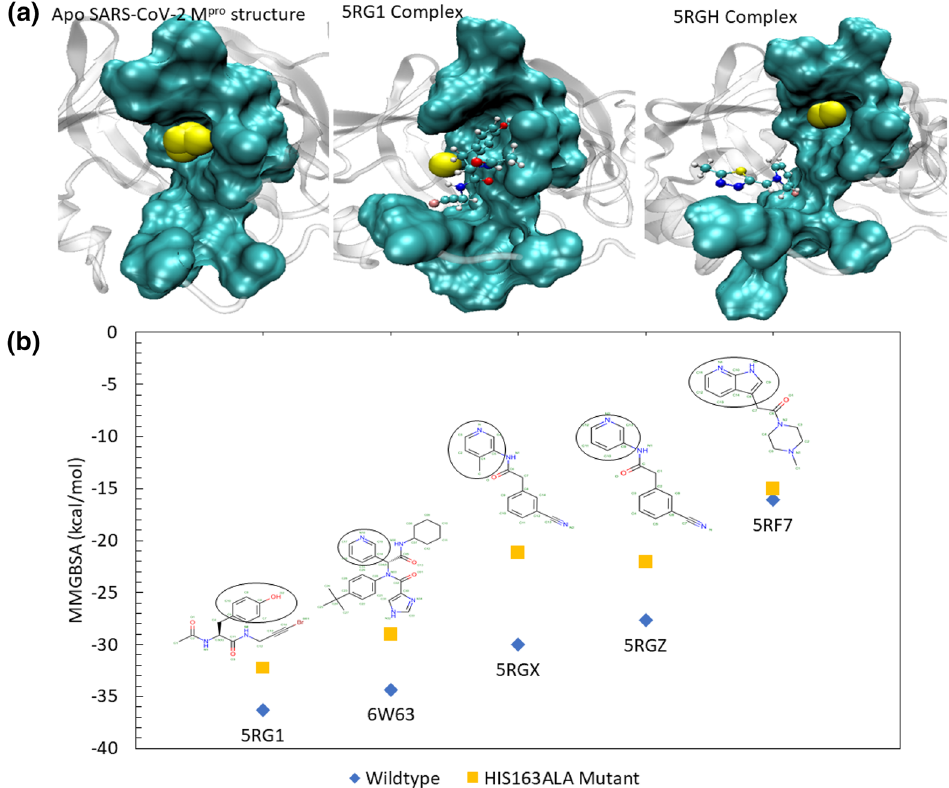
Figure 8. The identification of steric water sites in the apo and ligand-bound M pro complexes ( a ) along with the comparison of the binding free energy of the wildtype (WT) and HIS163ALA mutant complexes of the select systems ( b ). ( a ) The presence of steric water molecules (shown as yellow spheres) are found within the lateral binding pocket in the apo protein structure. When a ligand occupied the lateral site in the 5RG1 complex, the steric water molecules were displaced to the edge of the pocket, allowing for more stable ligand-binding. Nevertheless, when the ligand did not occupy the lateral pocket (as in the case of 5RGH structure), the steric water molecules are again observed within this lateral site. ( b ) Mutation of HIS163 to an alanine (ALA163) clearly led to a weak binding affinity between the selected ligand–M pro complexes. The molecular graphic in this figure was generated using VMD 1.9.3 63 ( a ) while the comparison plot in ( b ) was generated using Microsoft Excel 365 (https:// www. office.